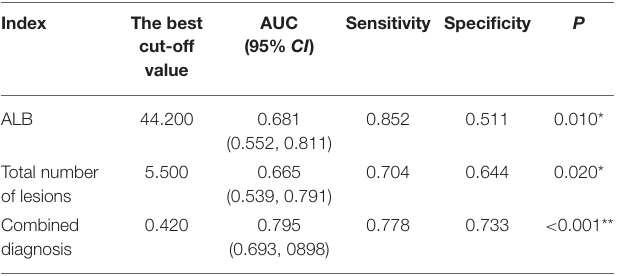
TABLE 3 | ROC analysis results of factors affecting the degree of disability in MS